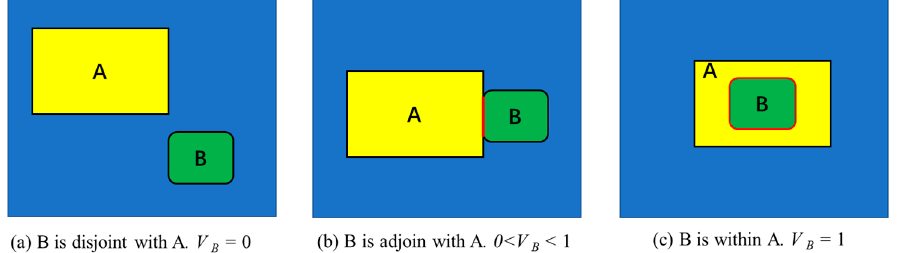
Figure 2. The schematic diagram for spatial ‐ adjacency relationships between target and nontarget landscape patches. If A is an urban landscape patch (target), and B is a natural landscape patch (nontarget), V B is the degree of spatial adjacency between landscape patch A and B. The red line in ( b , c ) represents the length of common edges between A and B, while ( a ) represents that there is no common edge between A and B. The blue background represents the spatial unit for analysis.